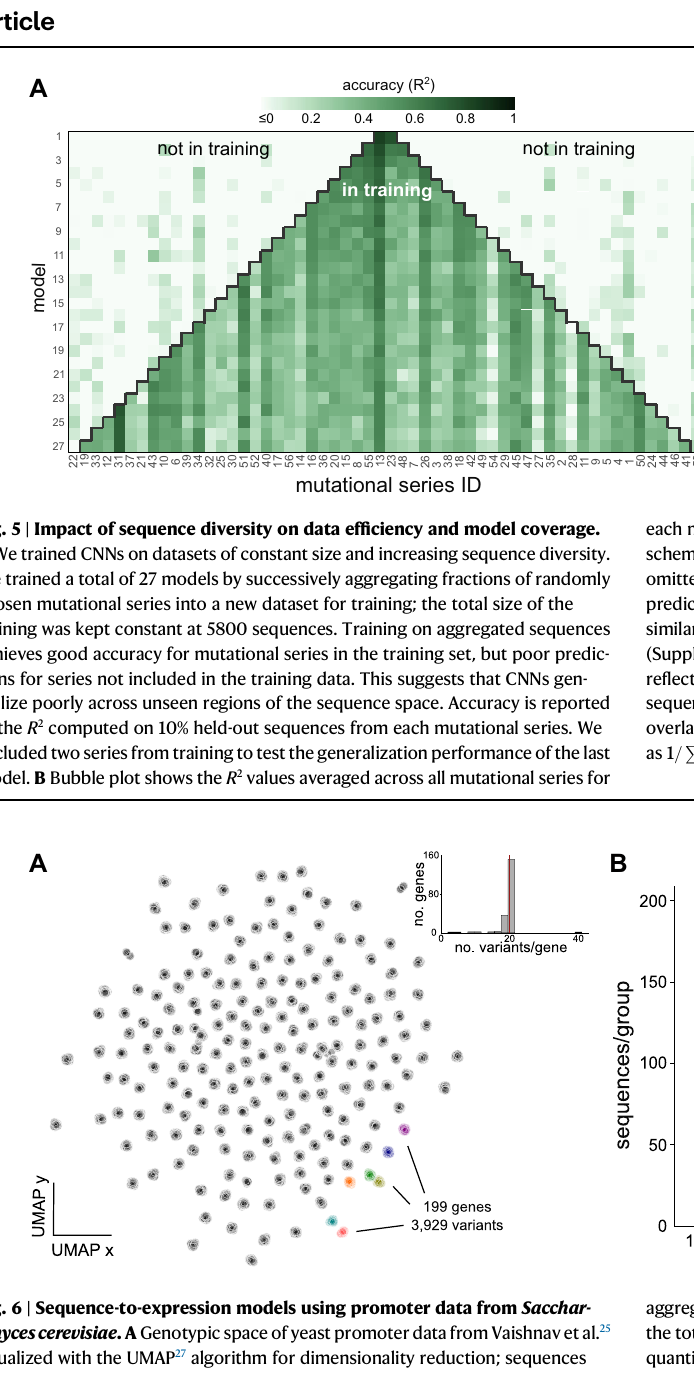
aggregating fractions of randomly chosen groups into a new dataset for training; thetotalsizeofthetrainingsetwaskeptconstantat400sequences.Accuracywas quanti fi ed with the R 2 score averaged across test sets from each group (~30 sequences/group) that were held out from training. Inset shows model accuracy in each test set. In line with the results in Fig. 5A, we observe that model coveragecanbeimprovedbyaddingsmallfractionsofeachgroupintothetraining set;weobservedsimilartrendsforotherrandomchoicesofgroupsincludedinthe training set (Supplementary Fig. S13). Details on data processing and model trainingcanbefoundintheMethodsandSupplementaryText.Sequencediversity was quanti fi ed as in Fig.